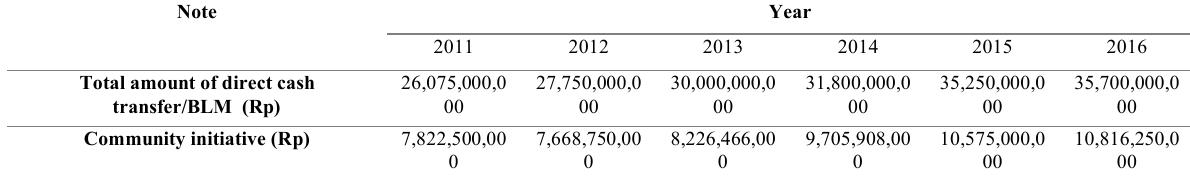
Table 1: Graph of Comparison between Direct Cash Transfer of GSMK Program in Tulang Bawang Regency during 2011 -